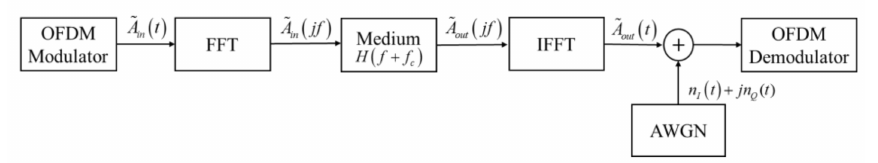
Figure 3. Flow chart of a baseband OFDM complex envelope evolution along the